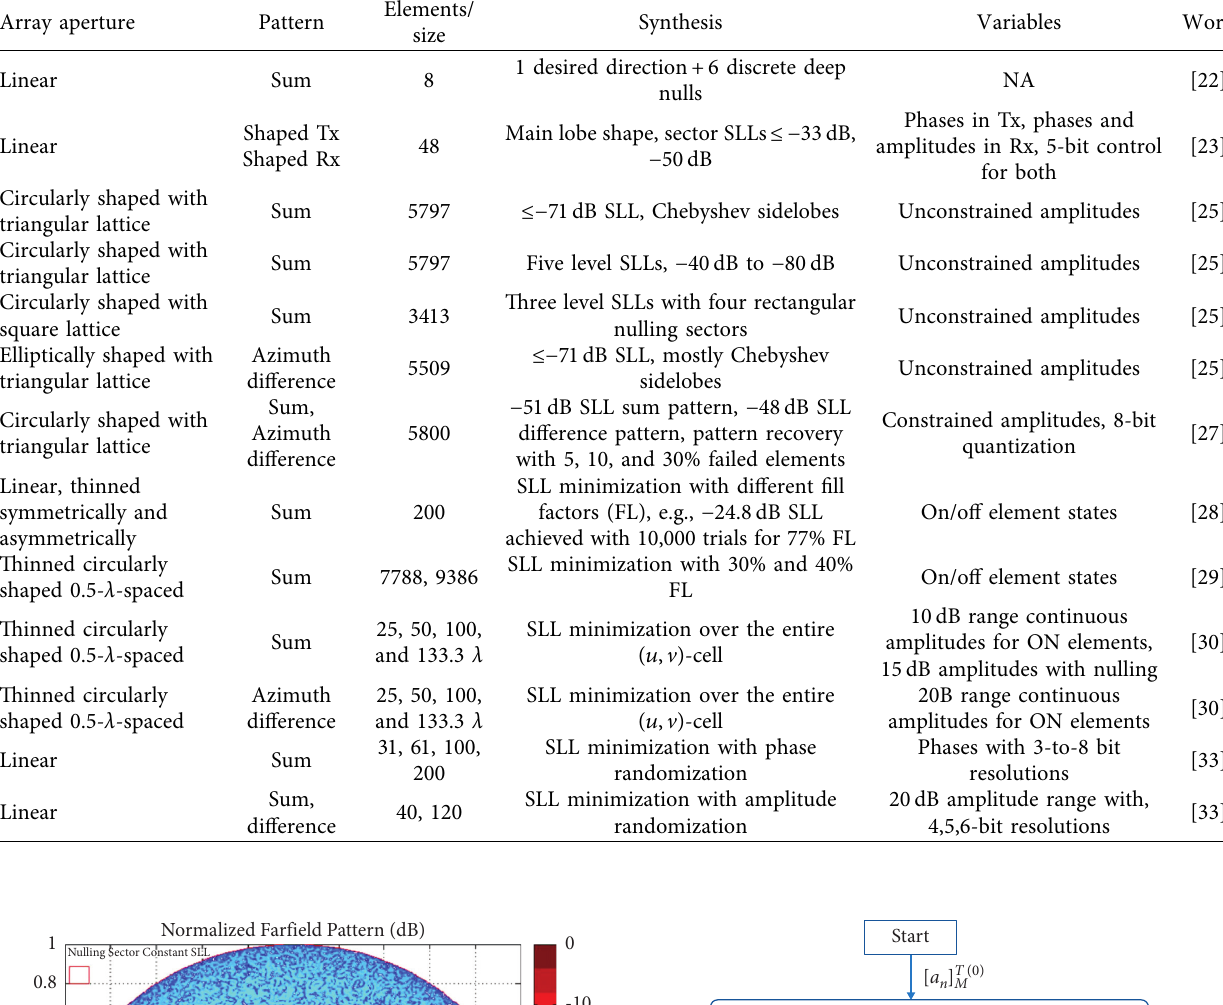
Table 1: The IFT synthesis method: applications and selected